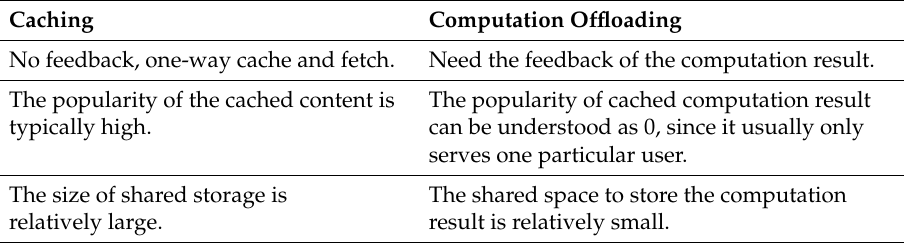
Table 1. Caching vs. computation